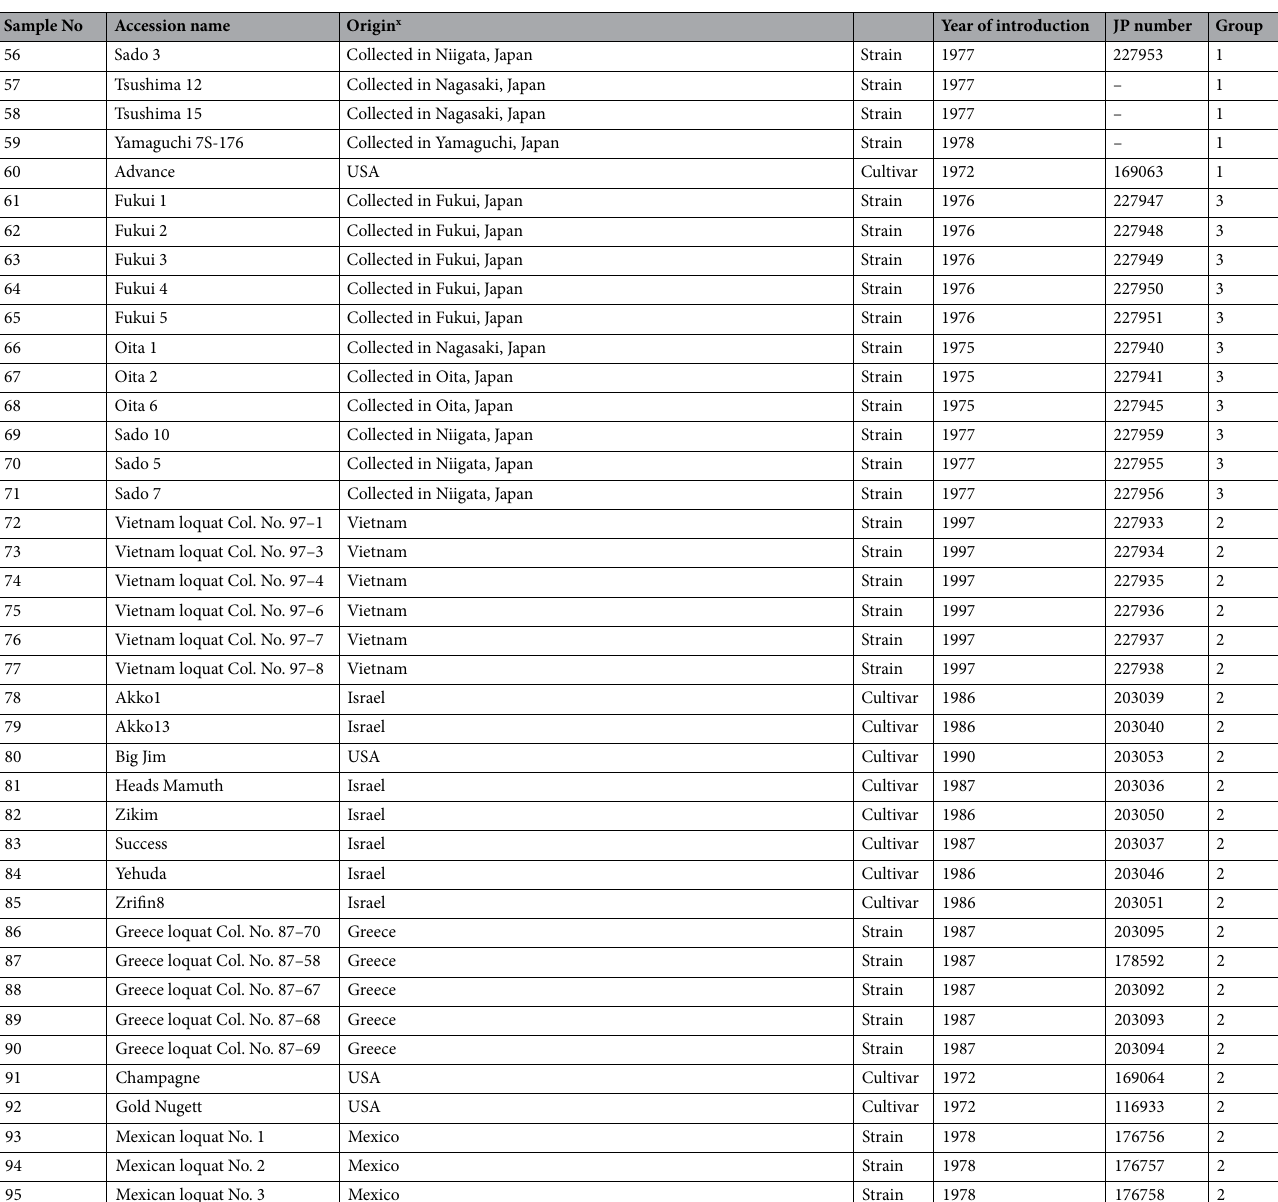
Table 1. Loquat accessions used in this study. z Technical replicates. y Name derived from the place name in China (in Japan, it is used as the name of the accession). x AFTDC:Agricultural and Forestry